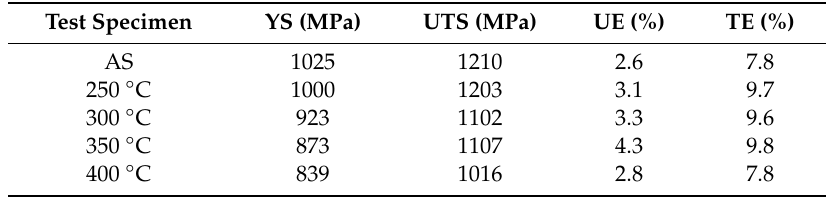
Figure 9. High temperature tensile properties of AS for ( a ) strength and ( b ) ductility. Table 5. High temperature tensile properties of AS.